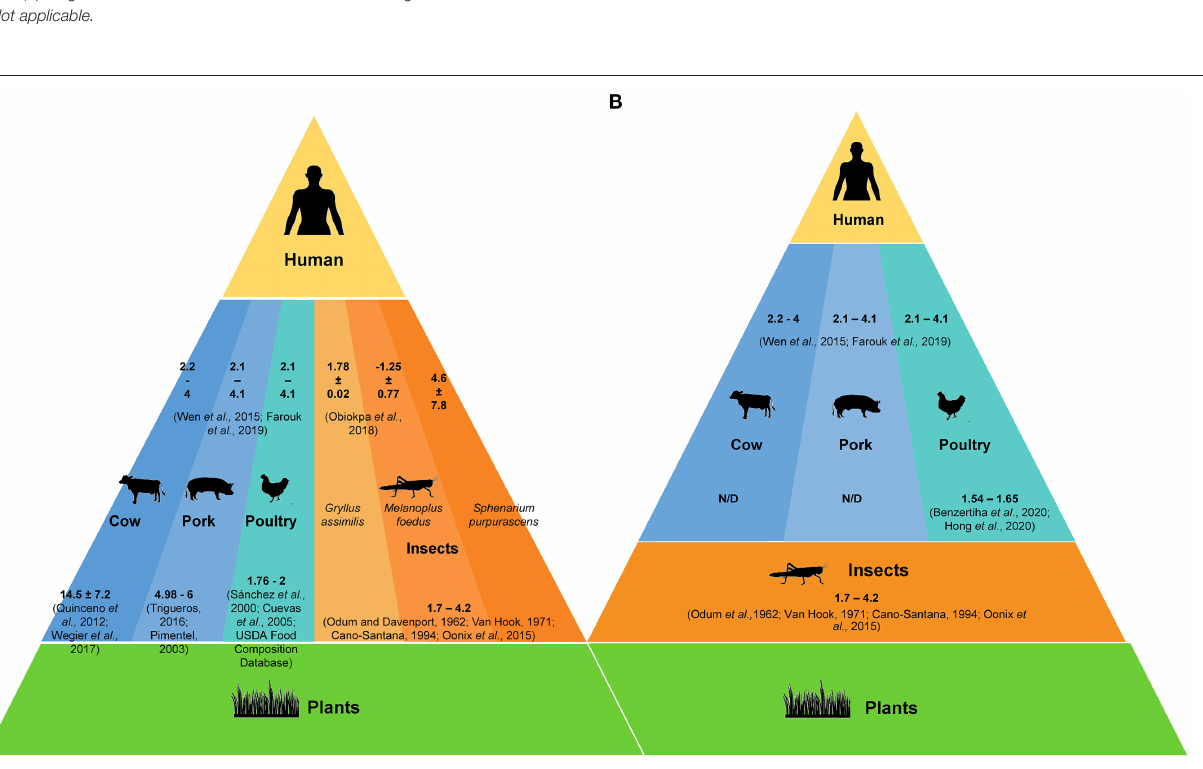
FIGURE 4 | Matter flow between trophic levels in different animal protein production systems: (A) Cumulative FCR values in conventional system with cow, pork, poultry, and insects as protein sources. (B) Cumulative FCR values in systems with an additional trophic level by including insects as food for farm animals.